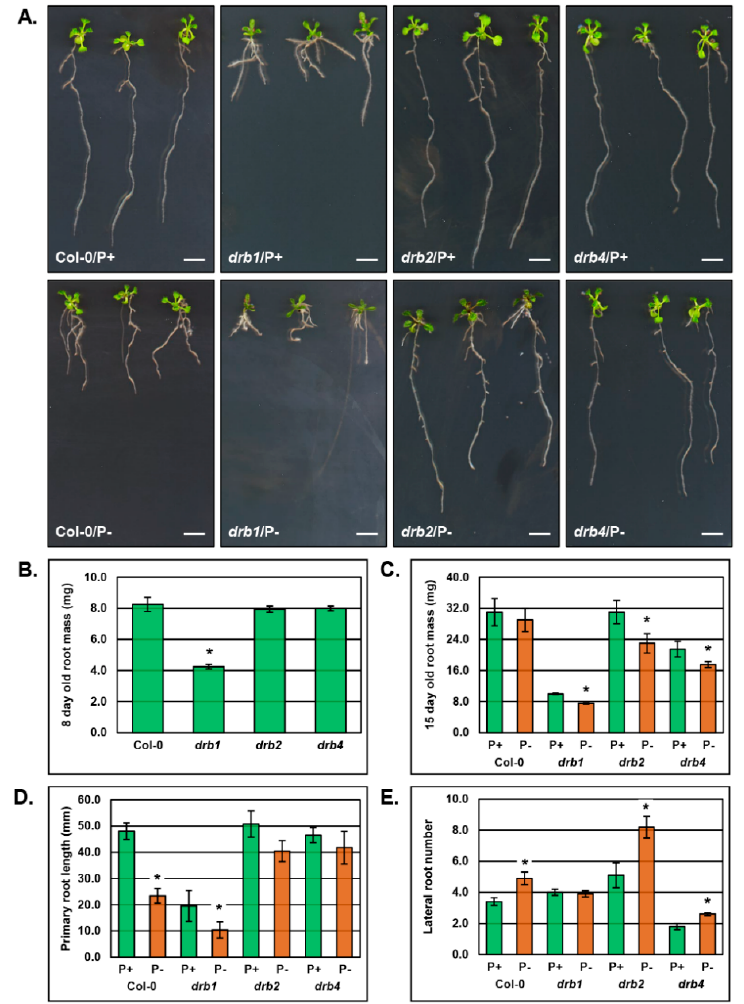
Figure 3. The root system phenotypes displayed by 15-day old Arabidopsis plant lines Col-0, drb1 , drb2 and drb4 post exposure to a 7-day period of PO 4 starvation. ( A ) The root system phenotypes expressed by non-stressed (top row of panels) and PO 4 -stressed (bottom row of panels) 15-day old Col-0, drb1 , drb2 and drb4 plants. Scale bar = 1cm. ( B ) Quantification of the root mass of 8-day old Col-0, drb1 , drb2 and drb4 seedlings cultivated under standard growth conditions. ( C ) The root mass of non-stressed and PO 4 -stressed 15-day old Col-0, drb1 , drb2 and drb4 plants. ( D ) The primary root length of non-stressed and PO 4 -stressed 15-day old Arabidopsis lines, Col-0, drb1 , drb2 and drb4 . ( E ) The number of lateral roots formed from the primary root of 15-day old Col-0, drb1 , drb2 and drb4 plants cultivated under standard growth conditions, or post the 7-day PO 4 starvation period. ( B–E ) Error bars represent the standard deviation of four biological replicates and each biological replicate consisted of a pool of twelve individual plants. The presence of an asterisk above a column represents a statistically significant difference either between non-stressed Col-0 plants and each assessed drb mutant post cultivation under either a non-stressed or stressed growth regime ( B ) or between the non-stressed and PO 4 -stressed sample of each plant line ( C-E ) ( p -value: * < 0.05; ** < 0.005; *** < 0.001).